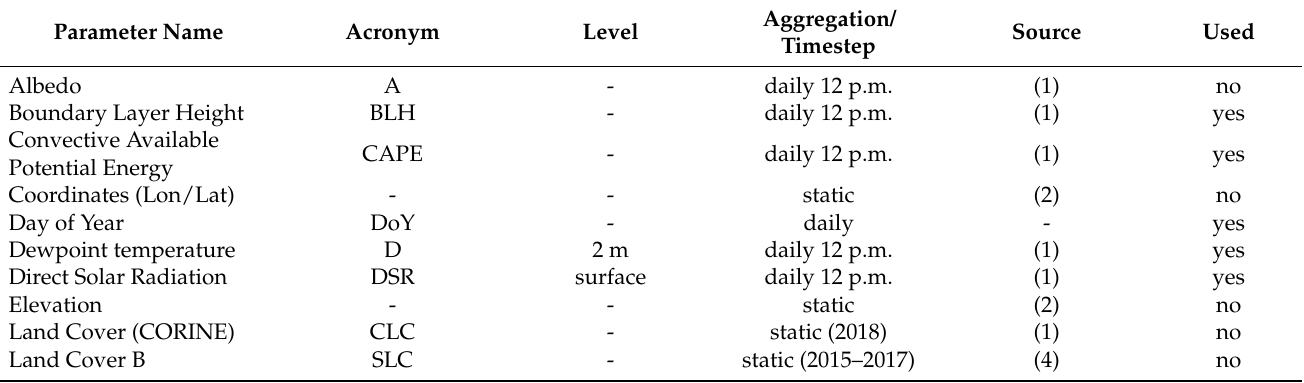
Table 2. Overview of the datasets used as proxy data for RF models. (1) ECMWF—see Section